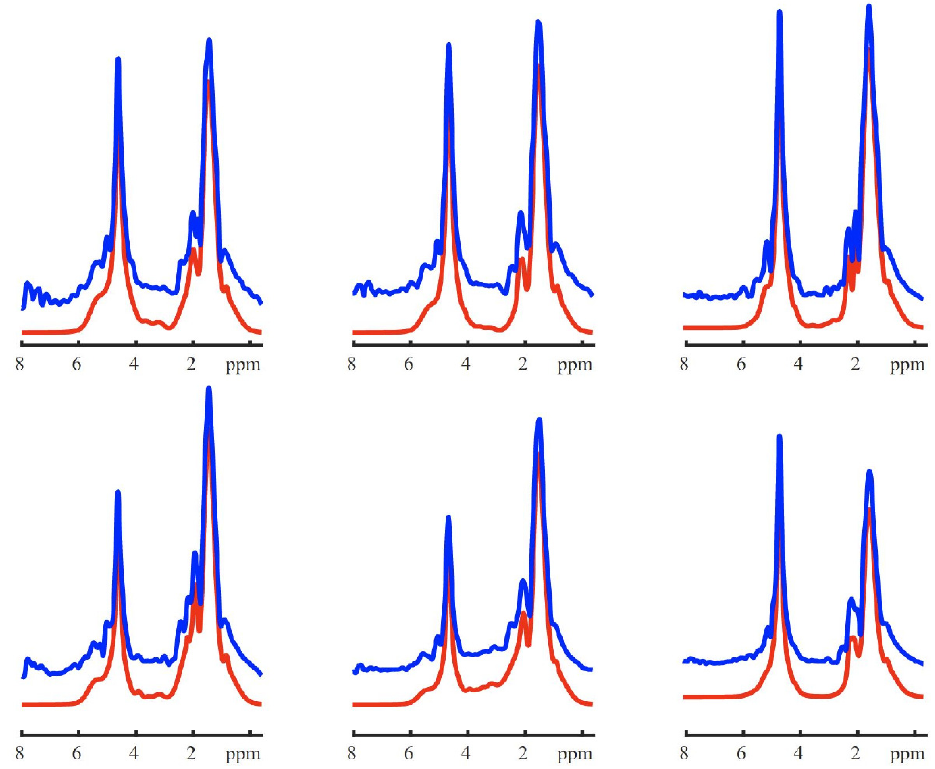
Figure 4. Example of lipid-only renal spectra fitting. Six spectra from adjacent voxels within the kidney are demonstrated. The blue lines represent the MRSI spectra, and the red lines represent their fit. The vertical offset between the blue and red line is due to the baseline correction implemented during fitting.